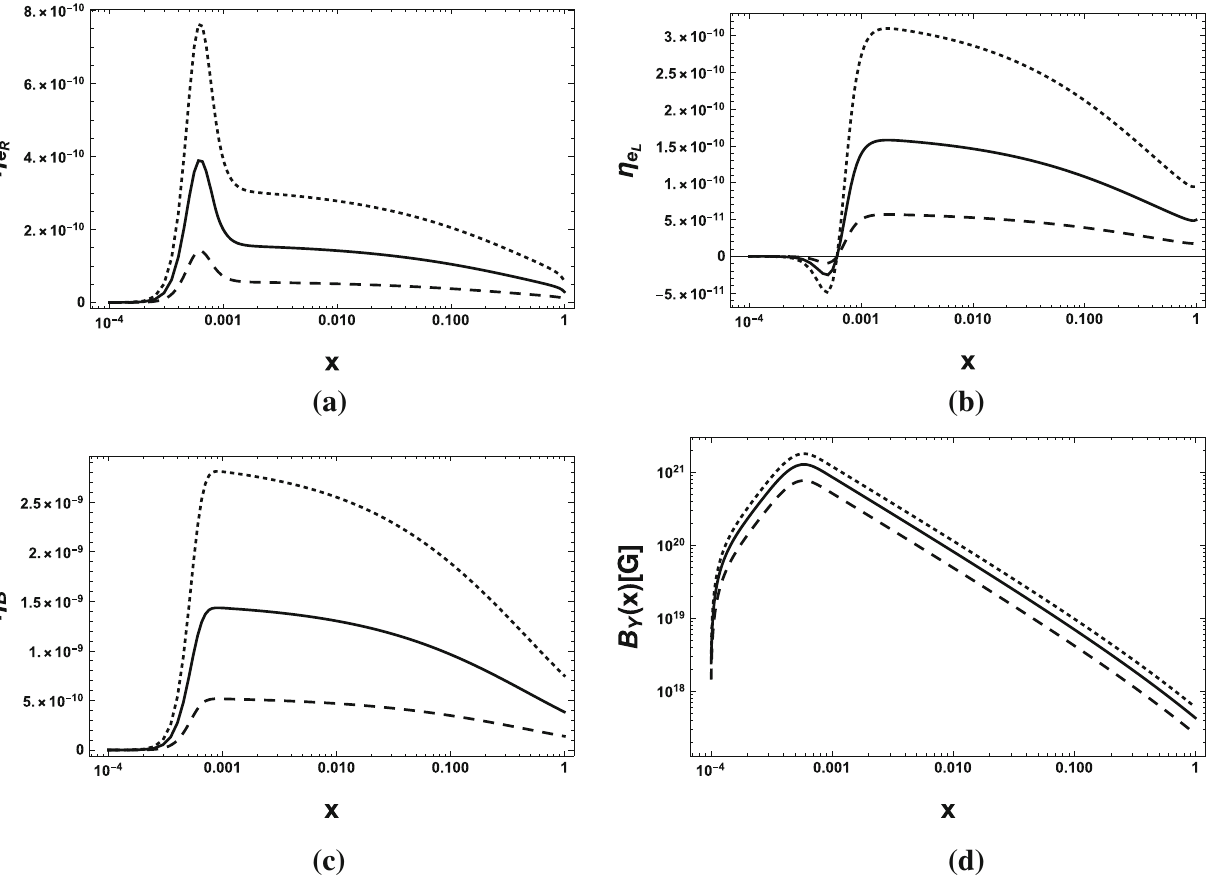
Fig. 1 Time plots of: a the right-handed electron asymmetry η e , b R the left-handed electron asymmetry η e , c the baryon asymmetry η B , and x 0 = 45 × 10 − 5 . The dashed line is for β 0 = 3 × 10 − 4 , the solid L and d the hypermagnetic field amplitude B Y , for various values of the amplitude of temperature fluctuation of e R . The initial conditions are: